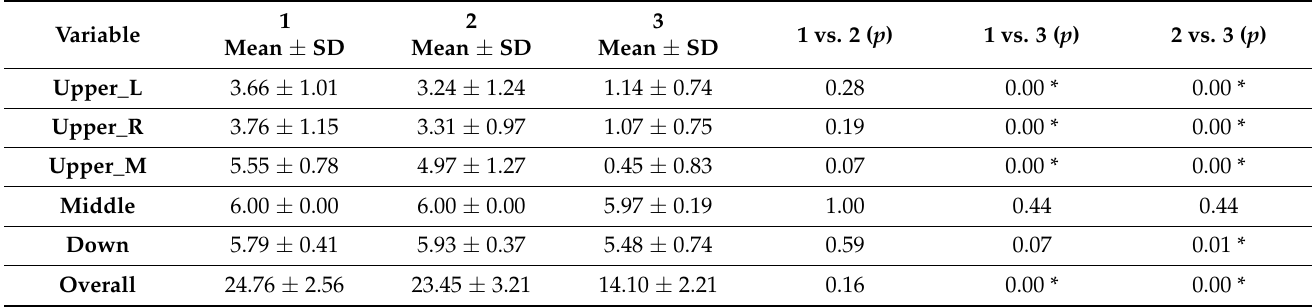
Table 1. Basic descriptive statistical parameters and Tukey’s post hoc results of ANOVA for each region for helmet users ( n = 22) (1—wearing only ski cap, 2—wearing ski cap and sunglasses, 3—wearing ski helmet and ski goggles).